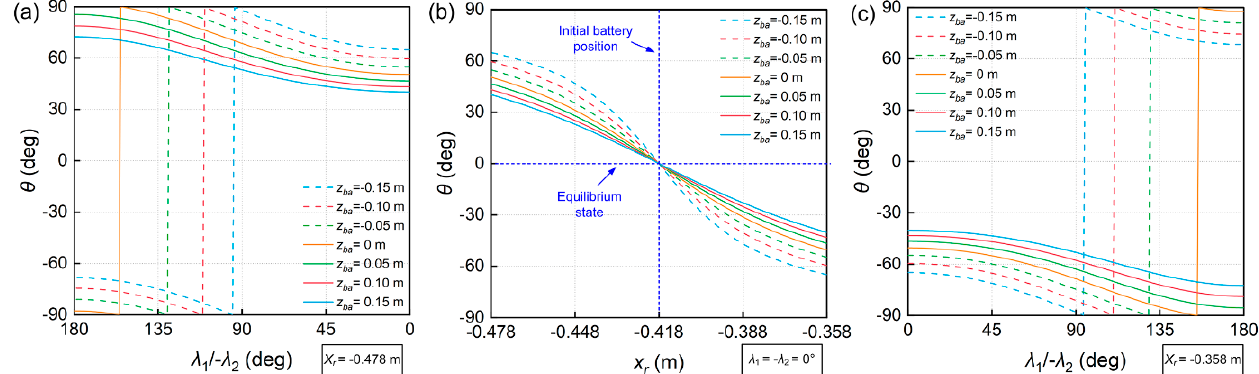
Figure 16. The regulation range of θ for different z ba with m ba equals to 2.0 kg: ( a ) θ vs. λ 1 / − λ 2 ( x r = − 0.478 m); ( b ) θ vs. x r ( λ 1 / − λ 2 = 0°); ( c ) θ vs. λ 1 / − λ 2 ( x r = − 0.358 m).